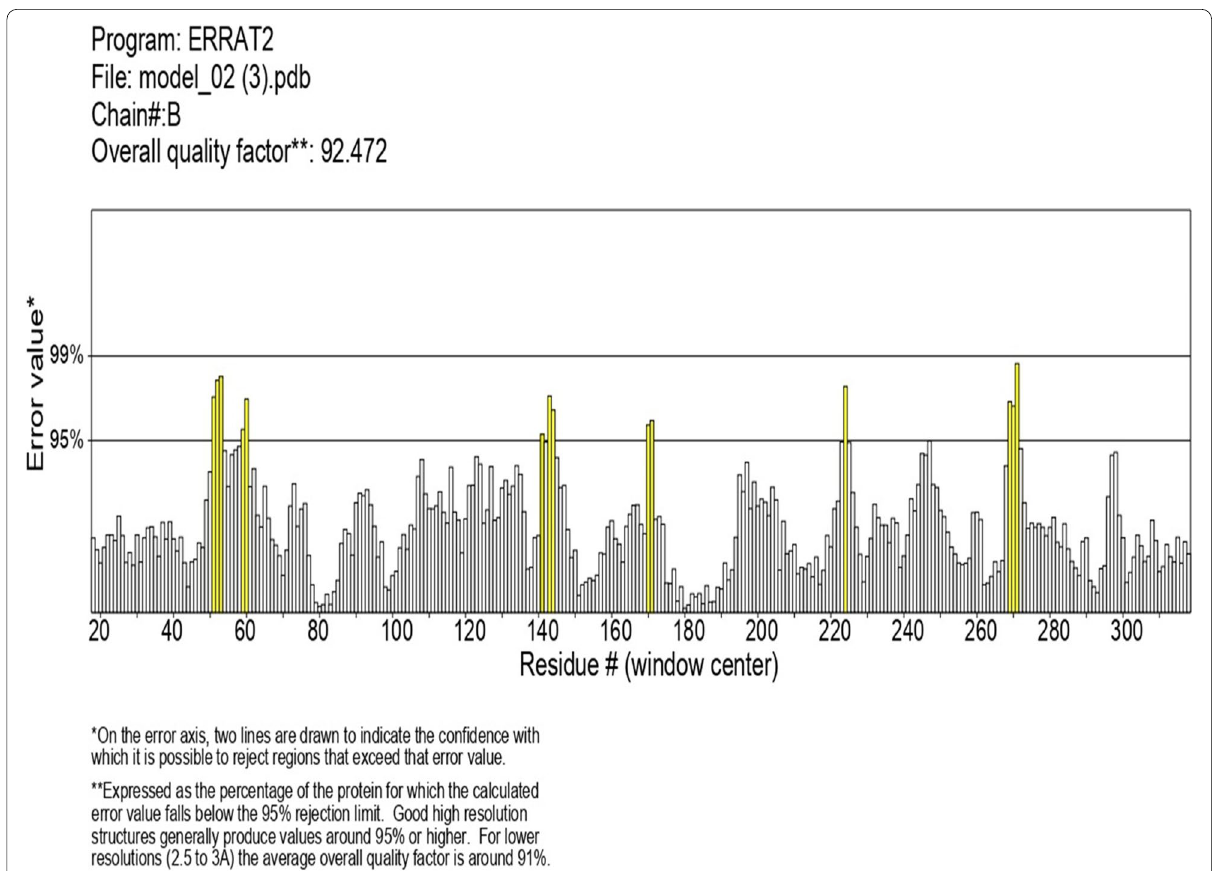
Fig. 6 ERRAT plot of Arabidopsis thaliana catalase model with overall quality factor